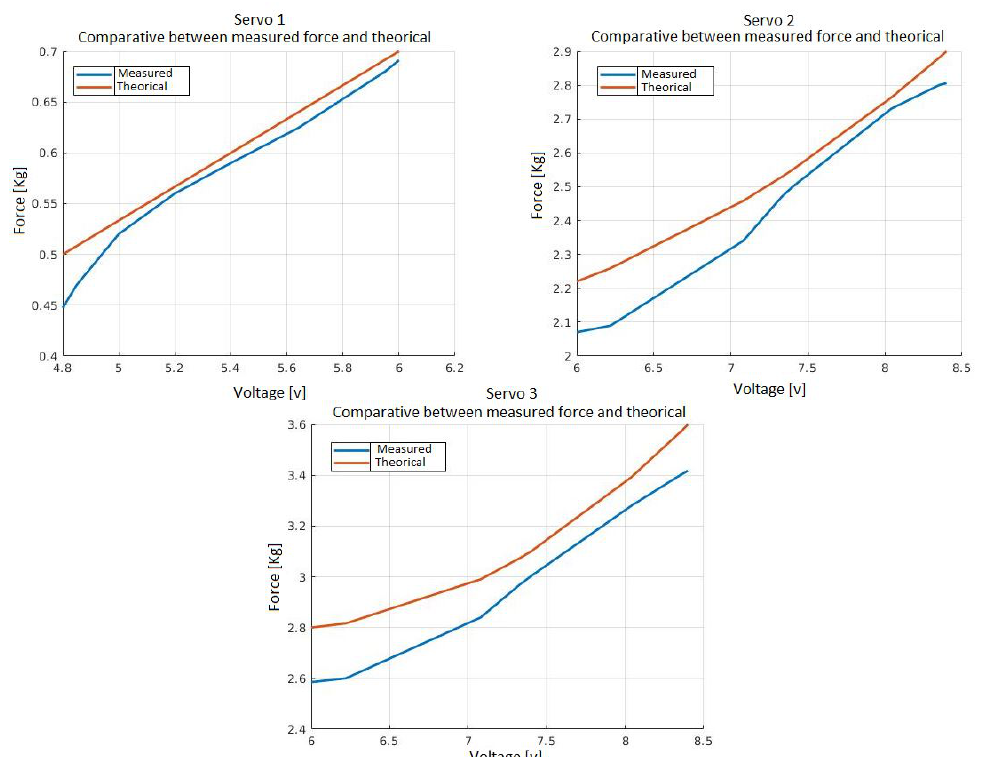
Figure 10. Comparison between the theoretical force and the real force performed by the soft limbs according to the voltage applied to the servos. The orange line represents the theoretical measurements and the blue line represents the experimental measurements